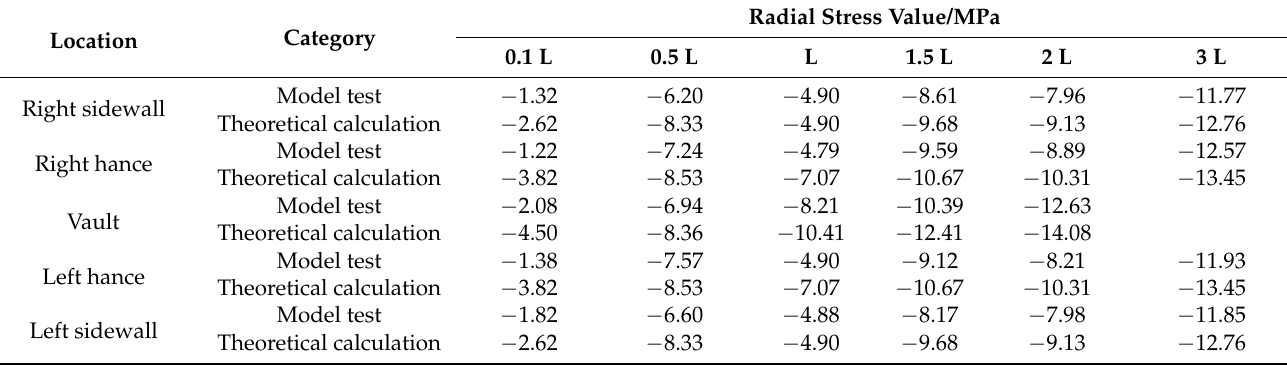
Table 4. Radial stress around the cavern.